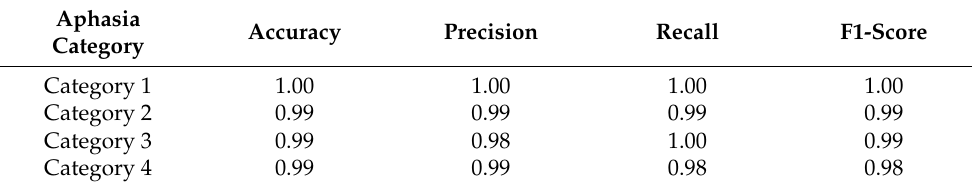
Table 11. Category-wise classification report of DNN model using 20 s audio